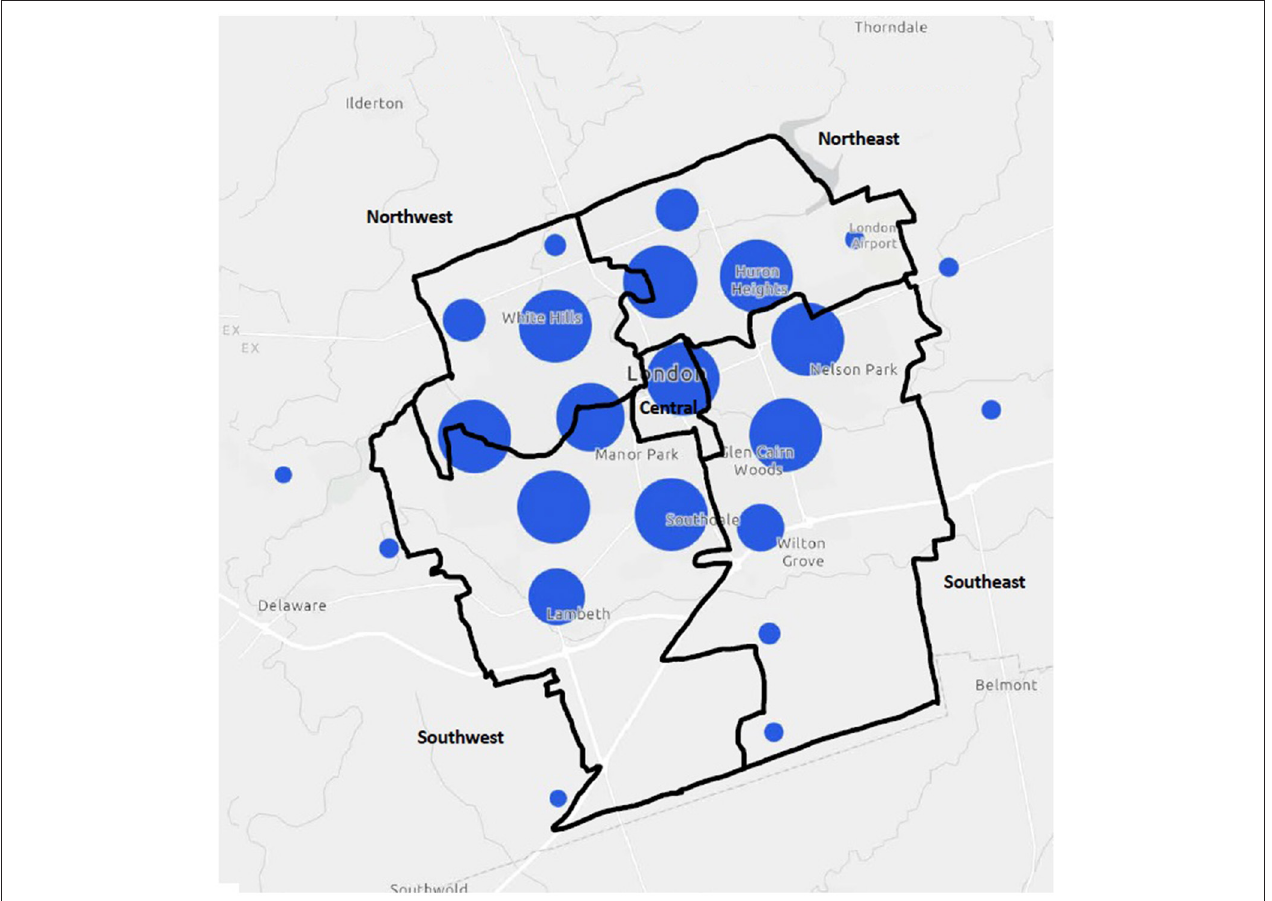
FIGURE 2 | Clustered sport delivery points in the five City of London planning